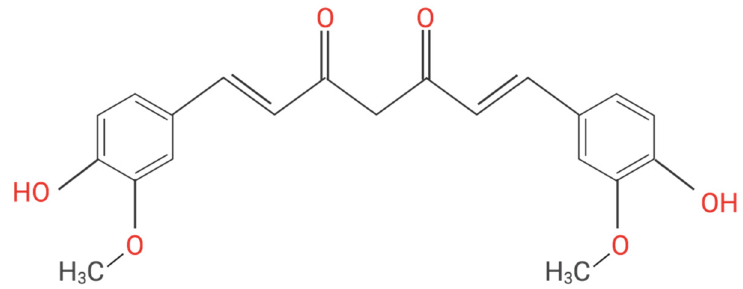
Figure 2. Molecular structure of curcumin. Curcumin is a symmetric molecule with chemical formula C 21 H 20 O 6 and molecular weight 368.38. It consists of three chemical entities in its structure: two aromatic ring systems containing o-methoxy phenolic groups, linked by a seven-carbon linker consisting of an α , β -unsaturated β -diketone moiety.